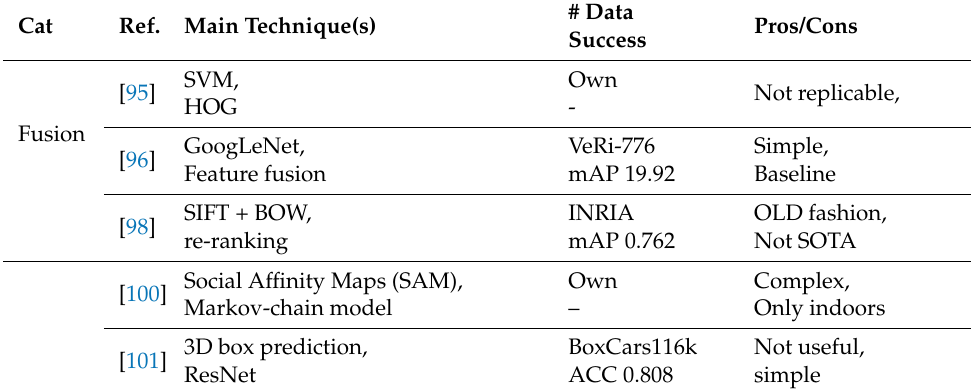
Table 9. Performance evaluation of the reviewed vehicle ReID using feature learning